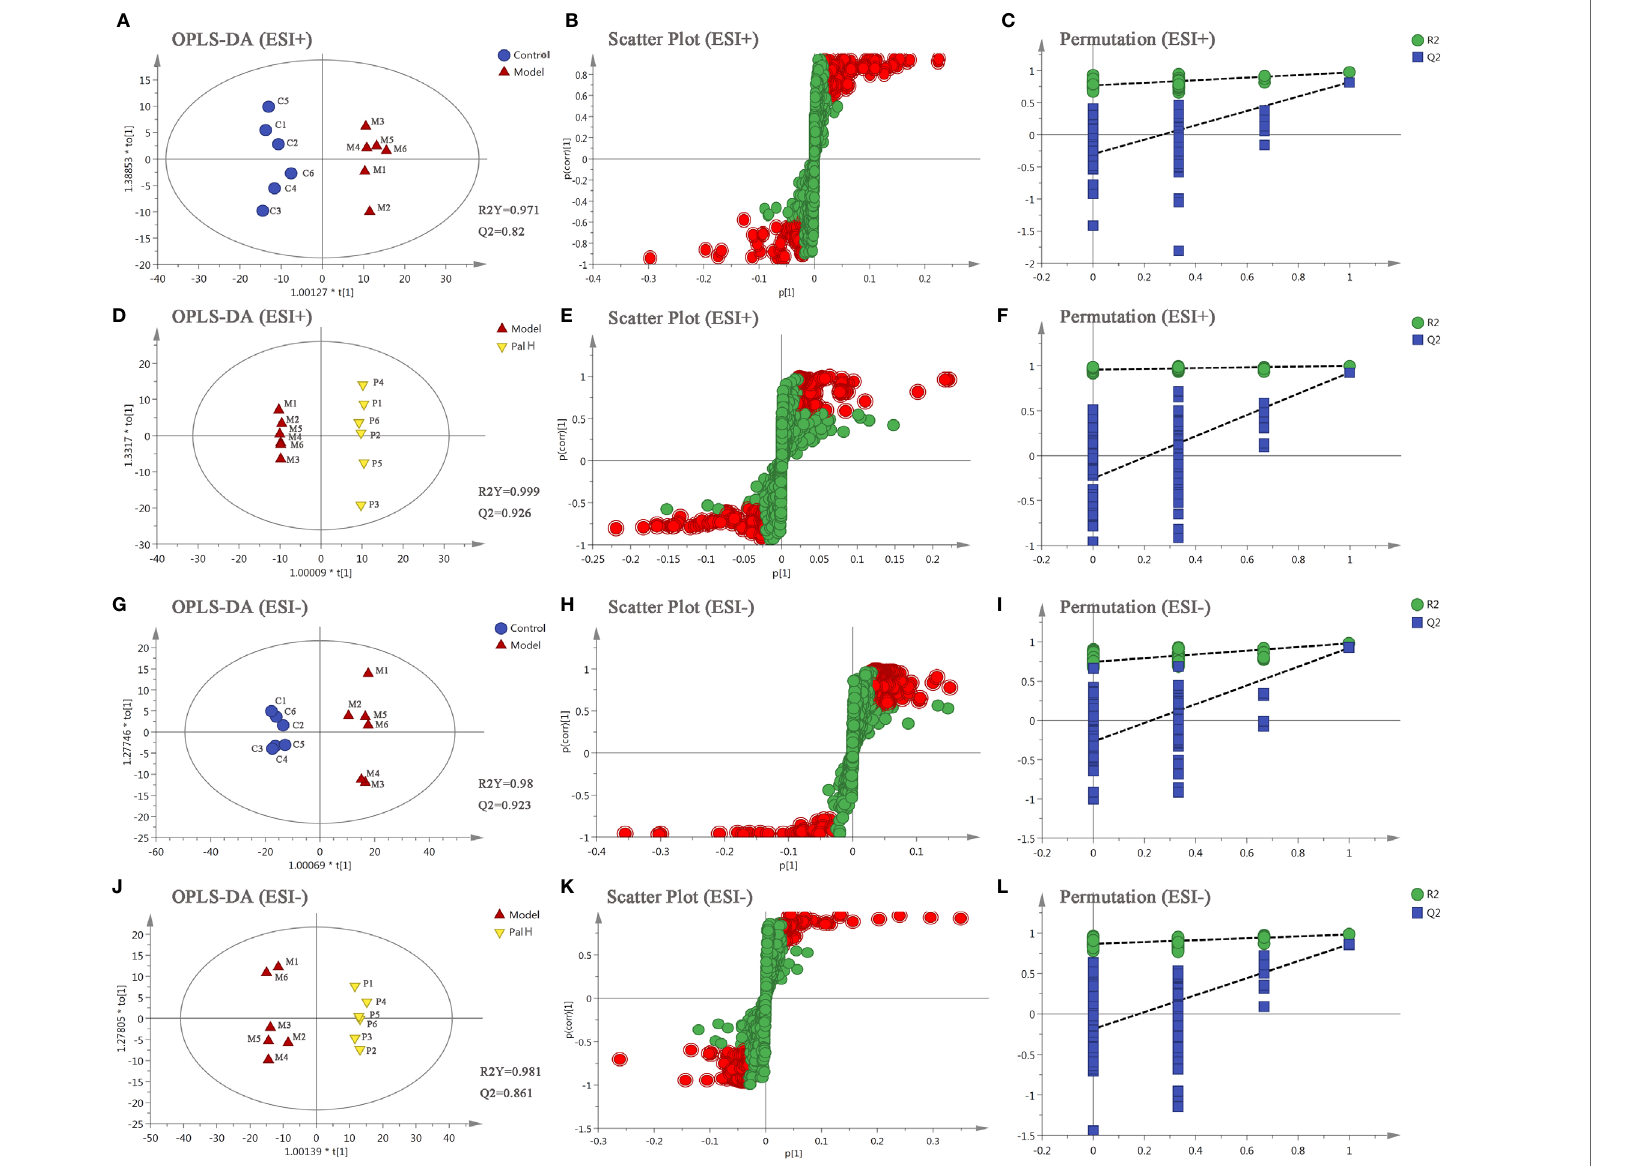
FIGURE 7 | The orthogonal-partial least squares-discriminant analysis (OPLS-DA) score plots, S-plots and 100-permutation test of serum metabolomics analysis. (A – F) ESI+ model. (G – L) ESI- model. PalH: (40